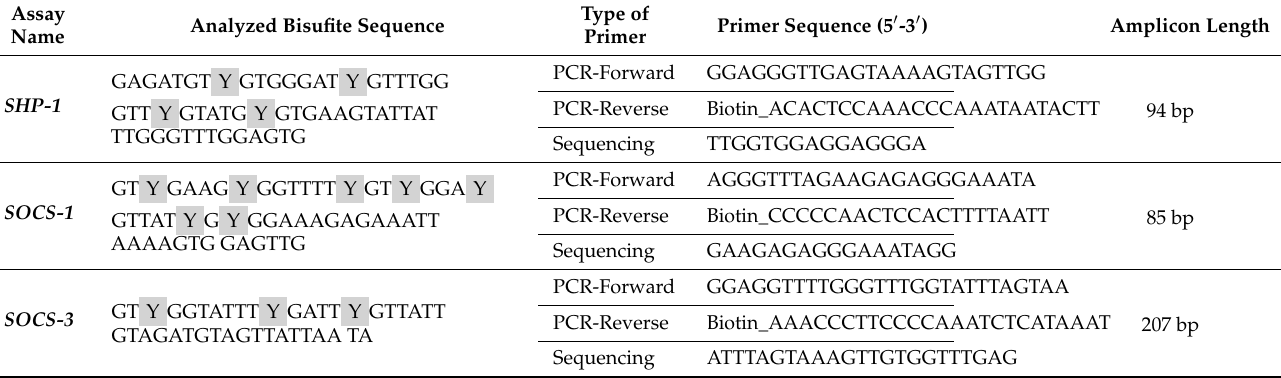
Table 6. Bisulfite-converted sequences, PCR and pyrosequencing primer sequences for pyrosequencing assays. CpG sites are highlighted in